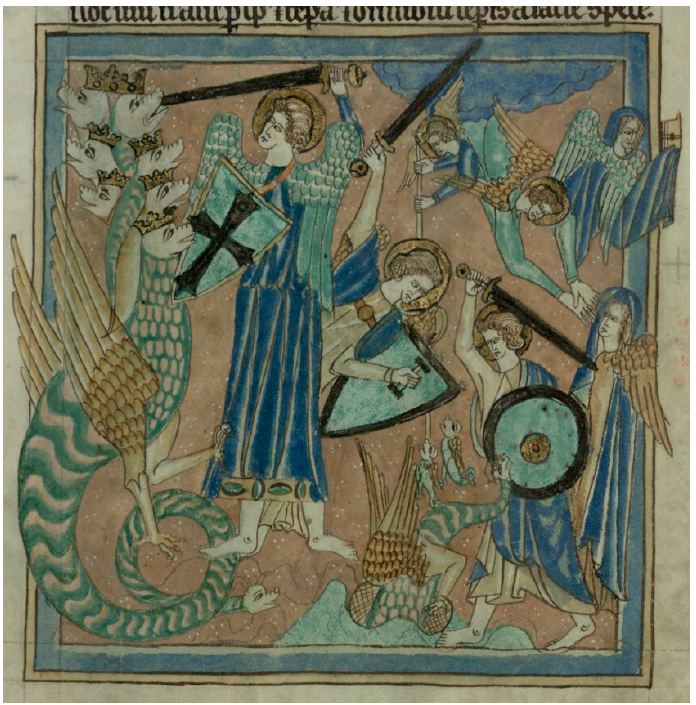
Figure 6. TC 10.6. (Cambridge, Trinity College, MS B.10.6) Fol.19 r , c. 1270–80. © The Master and Fellows of Trinity College, Cambridge.